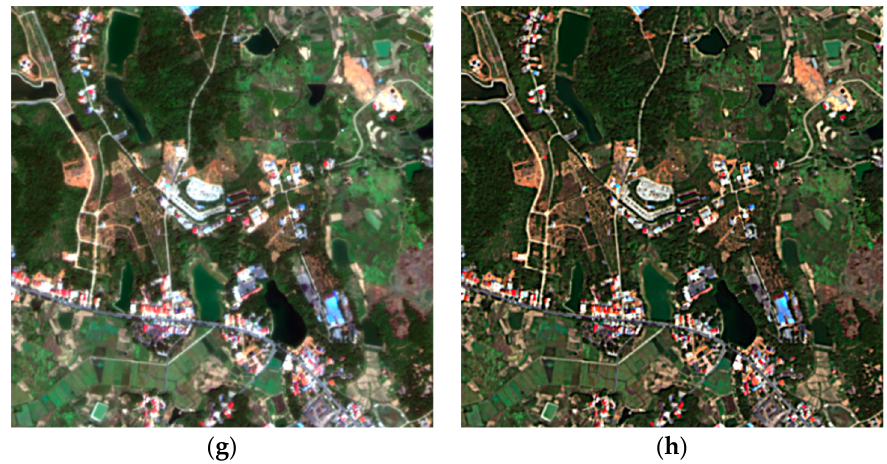
( g ) ( h ) Figure 3. Comparison of GF-2 images before and after QUAAC correction. True color composite images of TOA Radiance are shown on the left column and QUAAC − correcteded SR images are shown on the right column. The dates and locations from top to bottom are Dongting Lake on 11 November 2020 ( a , b ), Guangzhou on 29 January 2021 ( c , d ), Dongting Lake on 15 January 2021 ( e , f ), and Qiyang on 6 July 2021 ( g , h ).